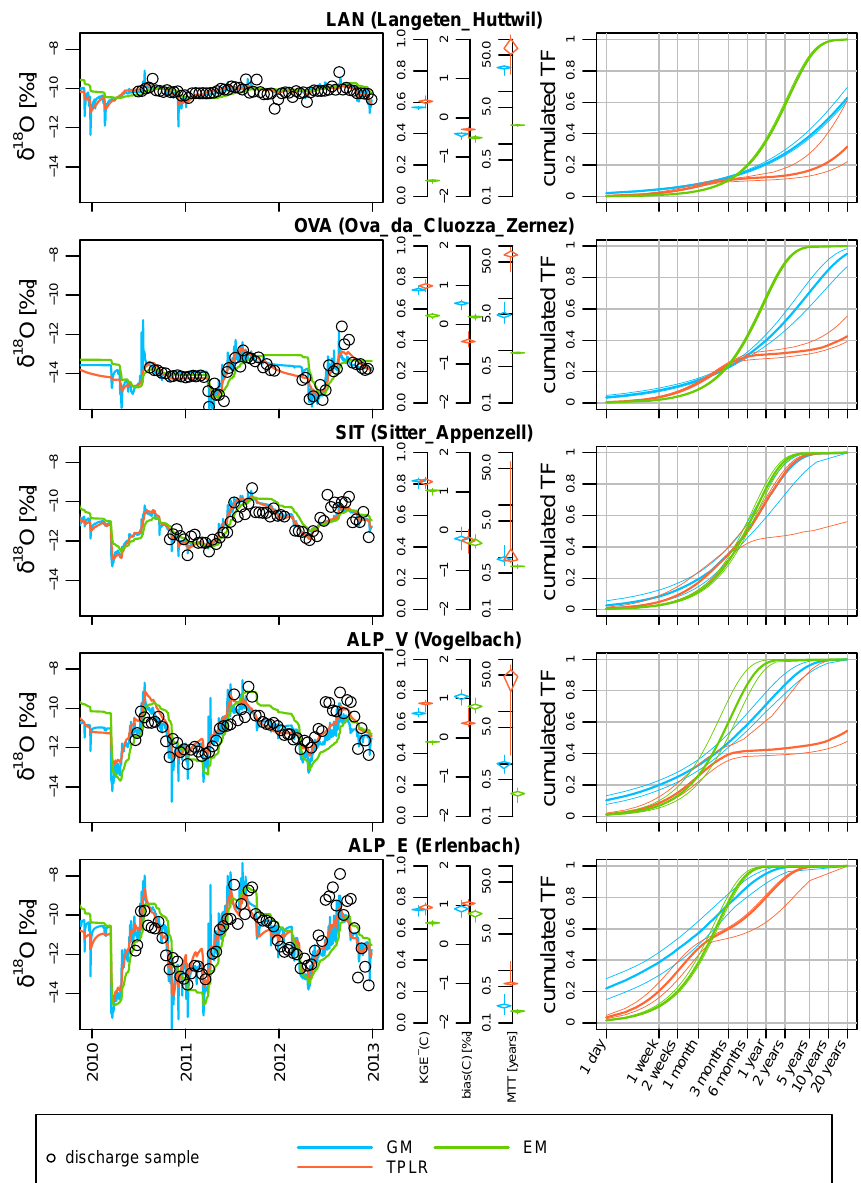
Figure 5. Optimisation results for selected catchments. Left panels: observed and predicted isotope concentrations in discharge. Right panels: cumulated TTDs (thicker lines represent the median values of all accepted solutions, thinner lines indicate their range). Centre panels: objective function values for isotopic composition predictions, biases of the predictions and MTTs implied by the optimised TFs; lines indicate the full value range, diamonds indicate the 25, 50 and 75 percentiles of the accepted